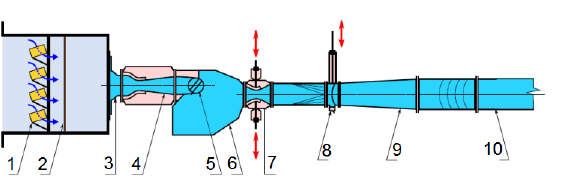
Figure 2. Scheme of the supersonic indraft wind tunnel. 1) silica gel drier 2) pebble filter 3)